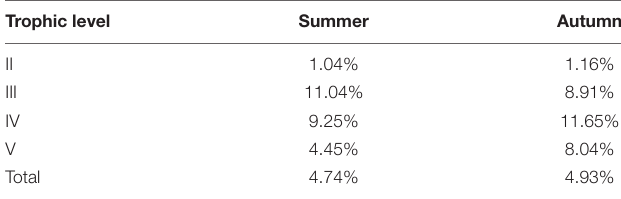
TABLE 4 | Energy flow efficiencies of the artificial reef food web in summer and autumn of 2019. Trophic level